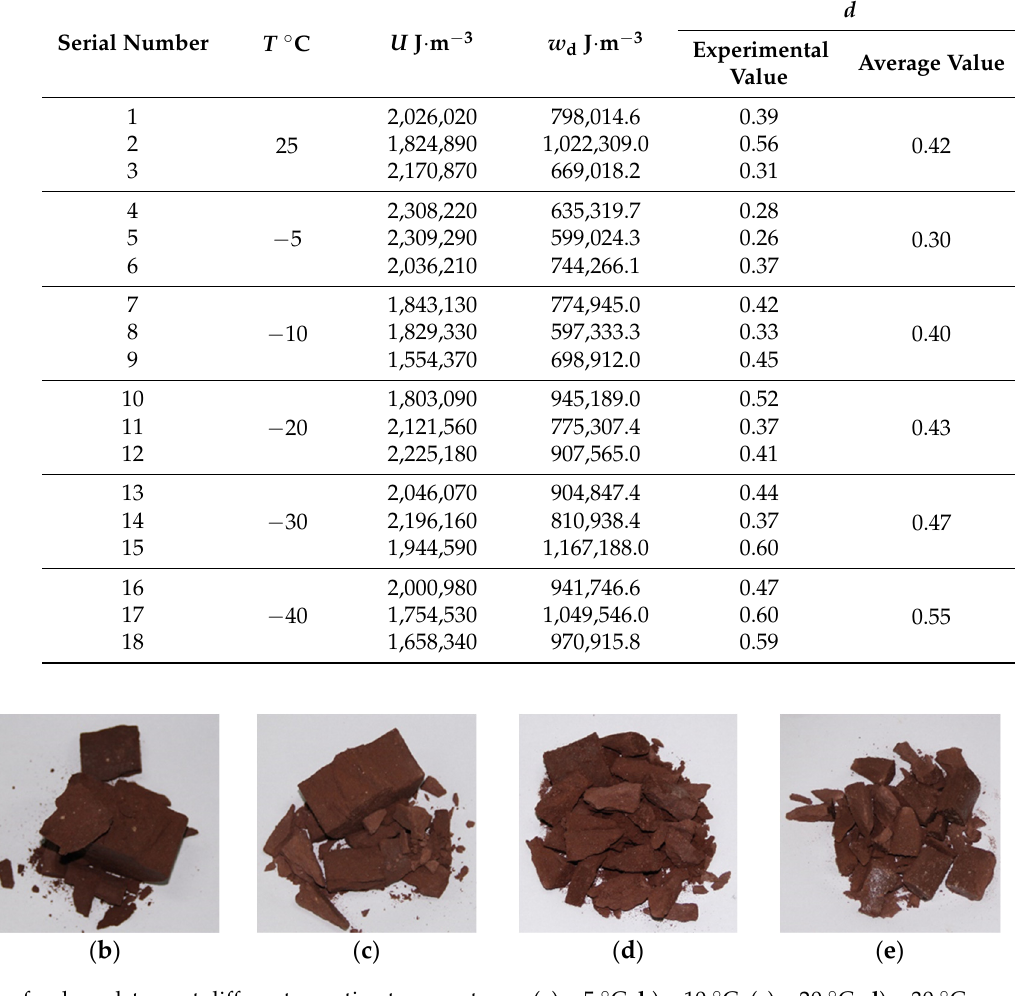
Table 2. The measured damage variables at different temperatures in the dynamic impact test.